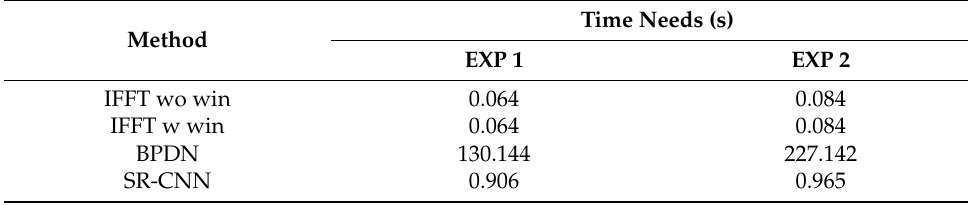
Figure 7. Range profiles of the target imaging result at azimuth 0 m and elevation 0 m. ( a ) Original results. ( b ) Local amplification.